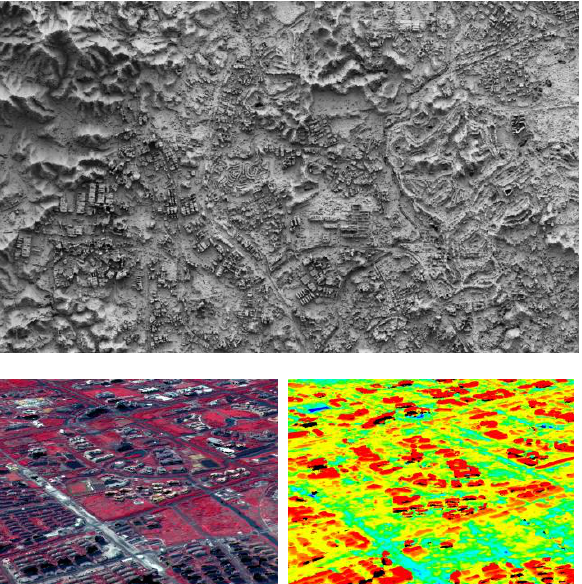
Figure 7. Pixel-wise DSM and orthophoto, point clouds from ZY-3 data generated using RSP. Top: a shaded DSM. Bottom: colorized point clouds: left: false color; right: height-coded color point clouds.